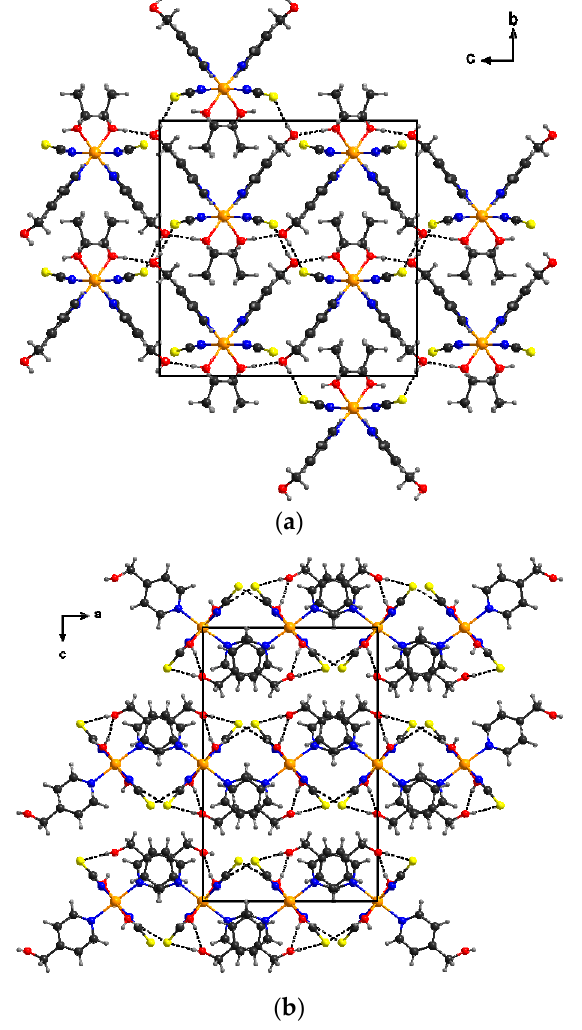
Figure 3. Crystal structure of 2 with view along the crystallographic b axis ( a ) and of 3 with view along the crystallographic b axis ( b ). Intermolecular hydrogen bonding is shown as dashed lines.